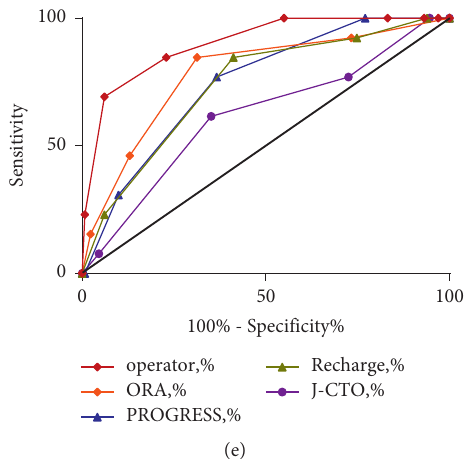
Figure 2: (a) J-CTO score predicts the curve of technical success. (b) Progress-CTO score predicts the curve of ROC. (c) ORA score predicts the curve of ROC. (d) Recharge score predicts the curve of technical success. (e) The ROC curve of the operator score was compared with that of each scoring